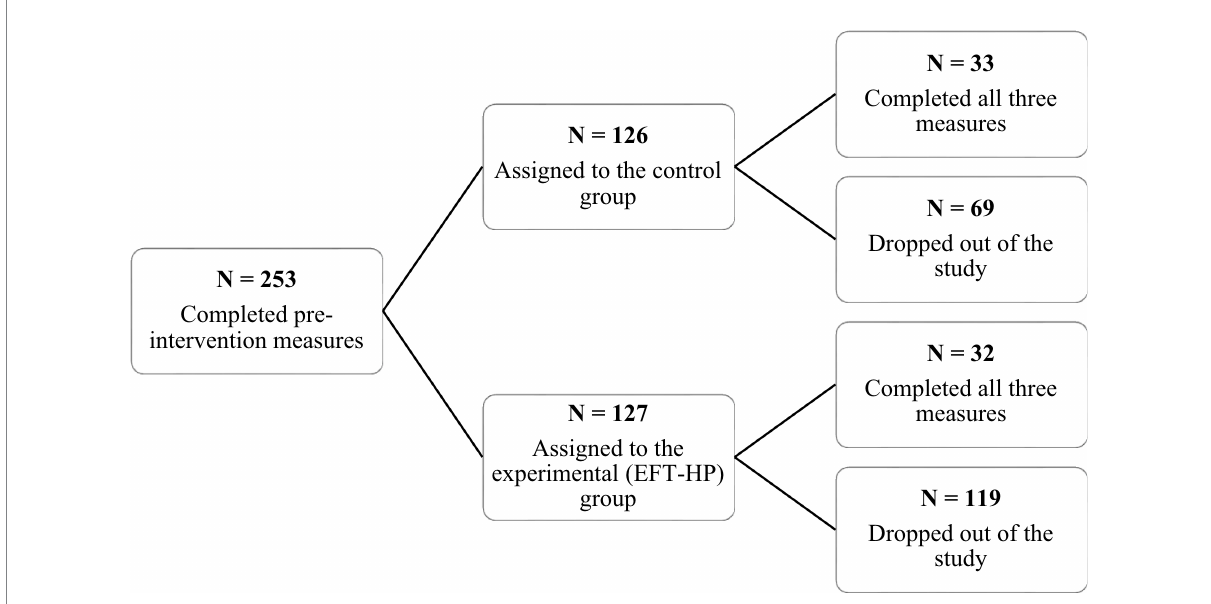
FIGURE 1 Chart of participants who completed the three phases of the EFT-HP intervention and attrition